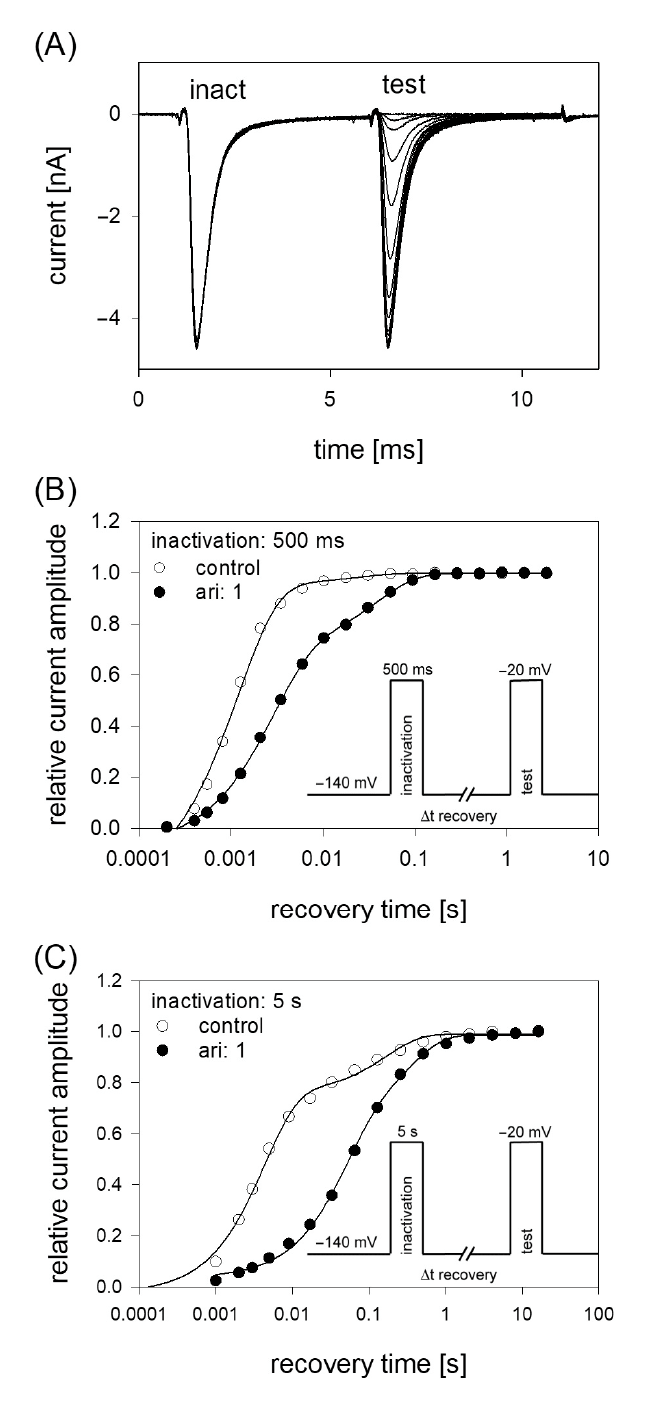
Figure 8. Recovery from inactivation. ( A ) Overlay of 19 original current traces obtained for control from the initial part of the conditioning inactivation pulses (inact.), which served as control and their corresponding test pulses (test). The variable recovery time is not illustrated. ( B ) Recovery from fast inactivation was performed using an inactivation time of 500 ms. The relative amount of available channels expressed as relative current amplitude (test/inact.) versus the recovery time at − 140 mV is illustrated. The pulse protocol is illustrated by the inset. Interval between individual sweeps was 10 s and aripiprazole was applied at 1 μ M. Solid lines represent fits with two exponential functions according to Equation (11). ( C ) Otherwise identical protocol as in (B), but with the inactivation time set to 5 s.